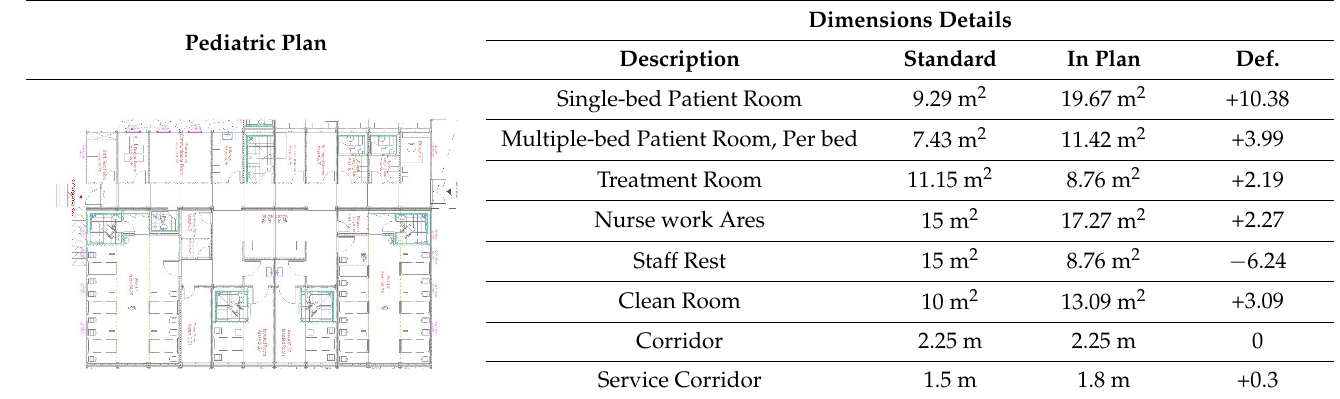
Table 4. Dimensional requirements of the pediatric department compared to standards.